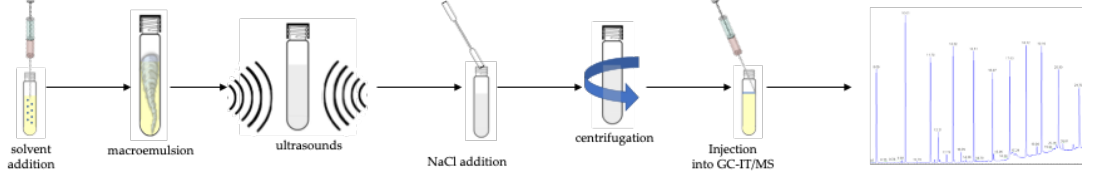
Figure 3. Workflow from sample preparation to data analysis of the entire analytical procedure. Table 4. Levels (ng g −1 ) of DMP, DEP, DiBP, DBP, BP-A, DEHP and DnOP in the 47 nectar honey samples analyzed. For abbreviations see Table 1. For LOQs see Table 3.